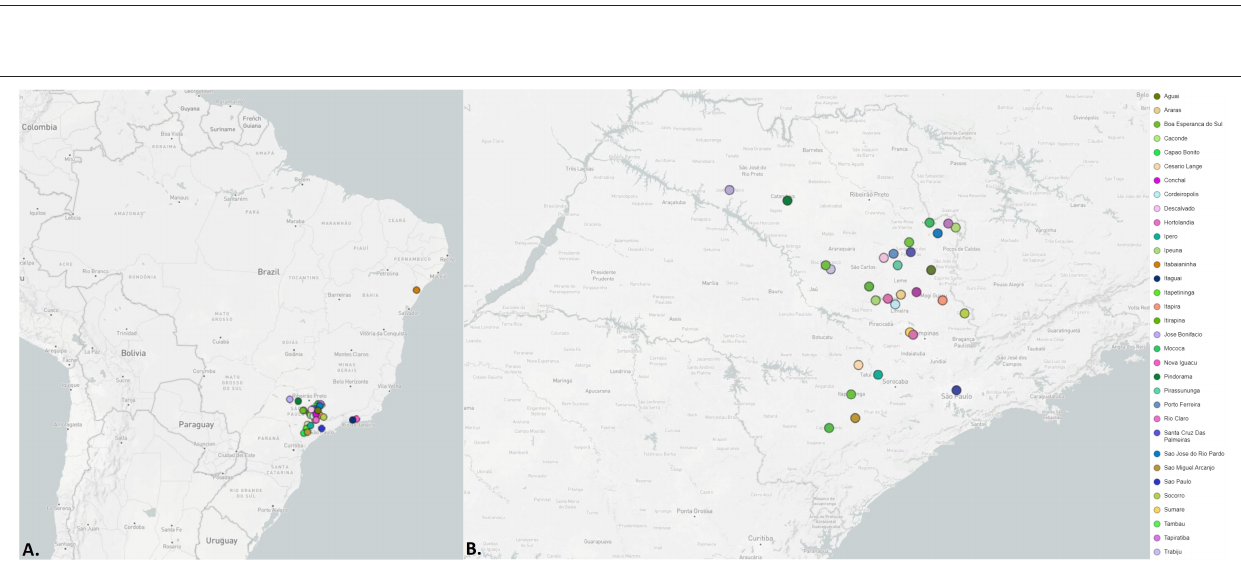
FIGURE 3 | Geographical location of detection of P.4 lineage. (A) . Brazil. (B) . State of São